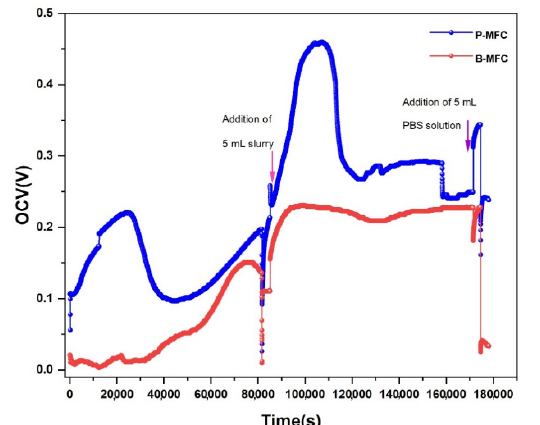
Figure 8. OCV values during five OCV_POL_PMax (P_MFCs and B_MFCs). The arrows indicate the addition of substrate (slurry) and PBS solution.